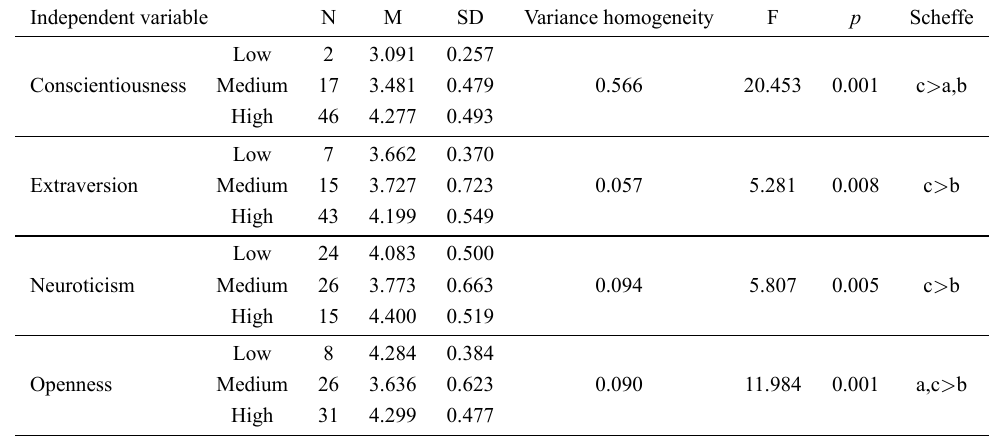
Table 7. Analysis of differences in preventive health behaviors for COVID-19 by personality